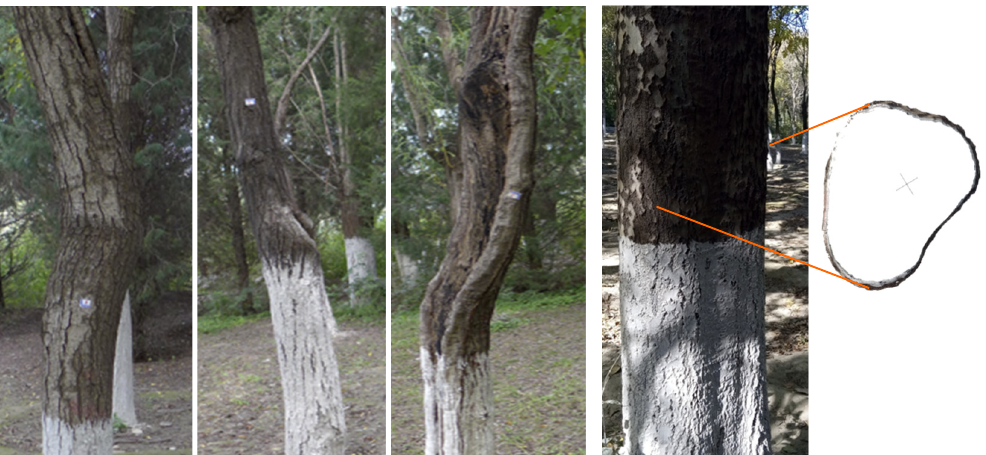
Figure 2. Large variations in tree trunks in plot 3. The cross-section shape of a white poplar tree is presented on the right.